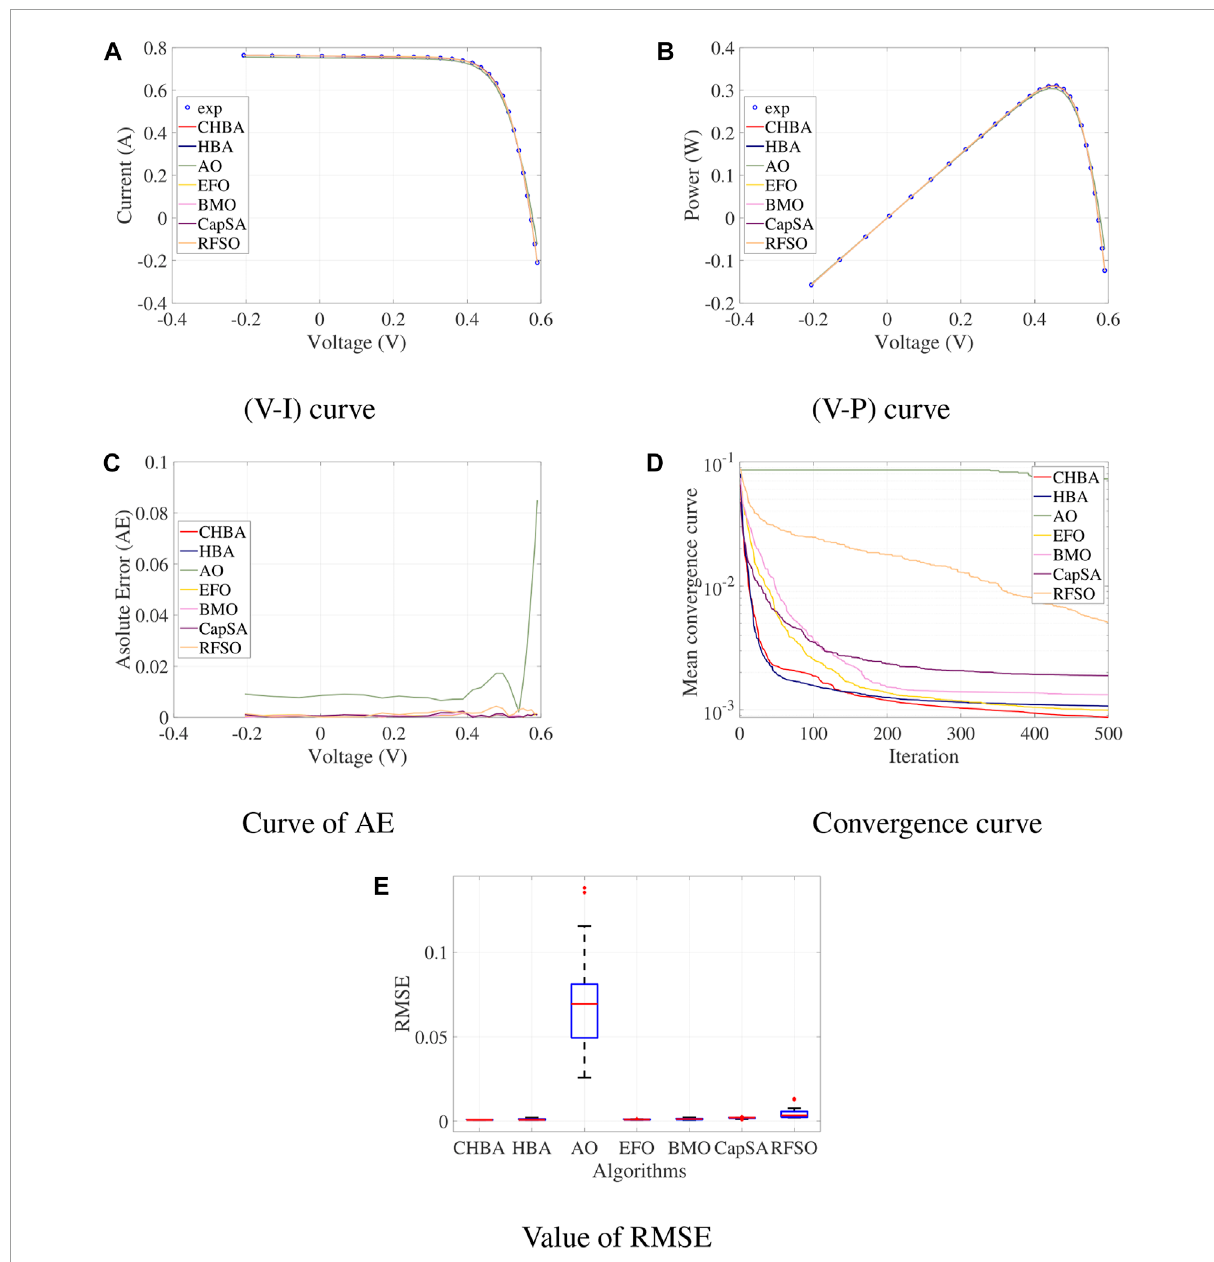
FIGURE 5 Behaviour of competitive techniques using SDM of RTC solar